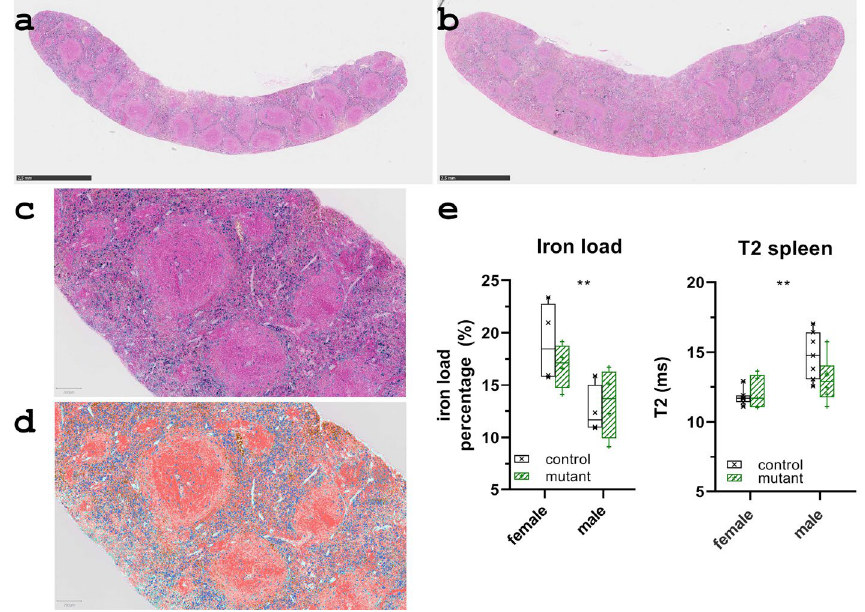
Figure 6. Quantification of the splenic iron load. ( a ) Example of a control spleen tissue and ( b ) of a mutant spleen tissue stained with Prussian blue. ( c ) The training region within a male control originally used for manual annotation with clearly identifiable, positively stained areas. ( d ) An example of the achieved performance of the trained pixel classifier, iron-loaded areas highlighted in dark blue. ( e ) Results of quantitative image analysis of spleen samples (females: 4/4, males: 4/4; age: 12 month) stained with Prussian blue confirmed the unchanged splenic iron load in C3H Kit N824K/WT mice and the general sex-specific iron status. Consistently, shorter T2 times were measured in the spleen of females compared with males, both at 12 months of age (**, p ≤